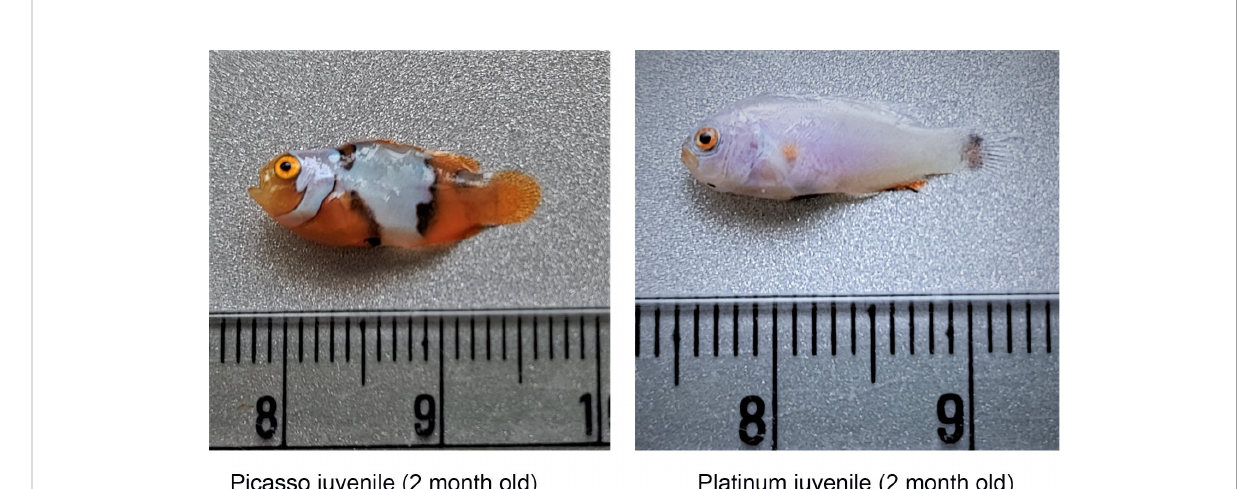
FIGURE 9 Juveniles of designer clown fi